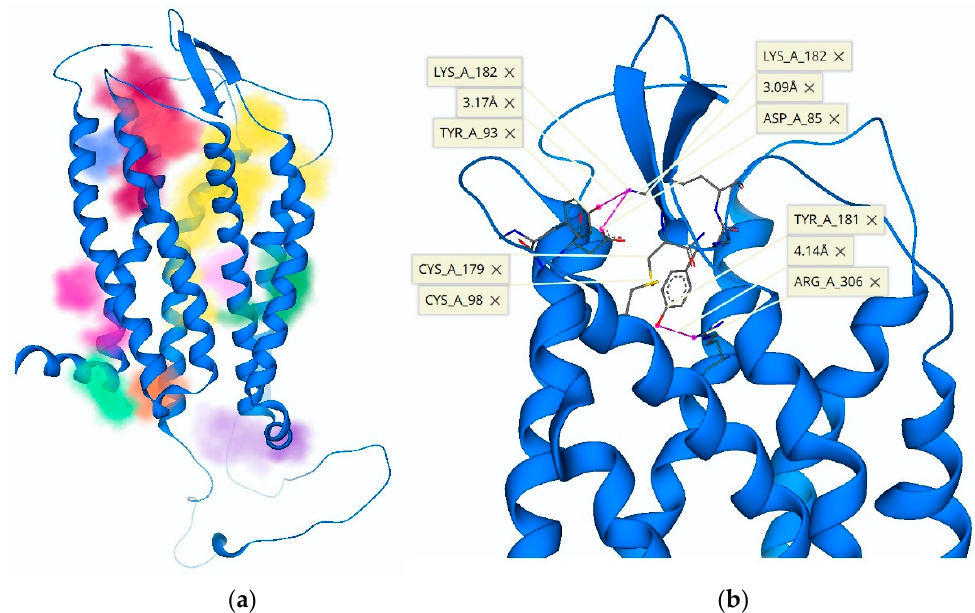
Figure 4. ( a ) The movement of ECLs creates unique binding pockets, highlighted in various colors. The binding pathway for TRH is shown in yellow and leads from the ECD down to the TMB active binding site. ( b ) ECL-2 is capable of interacting with multiple ECDs such as the N -terminus or other ECLs. Shown here is an ion–ion interaction between Lys-182 of ECL-2 and Asp-85 of ECL-1 that causes Tyr-181 to project downward towards the opening of the TMB channel.